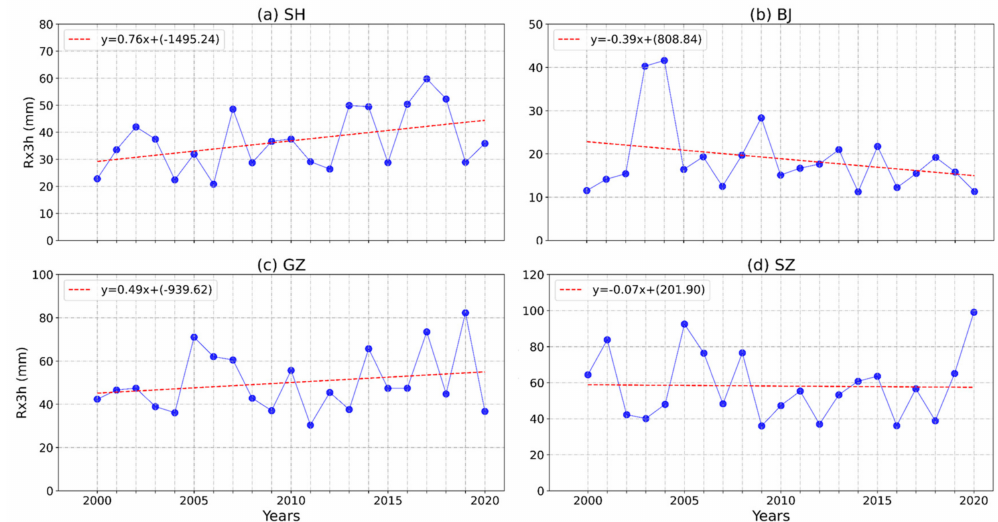
Figure 5. Trend analysis of Rx3h series in study cities (The blue dots are the values of Rx3h, and the red lines are the trend lines calculated by Sen’s slope